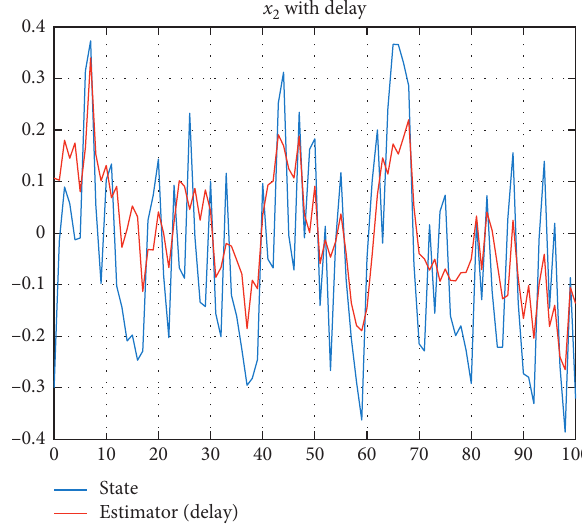
Figure 2: The second state component x (delay).